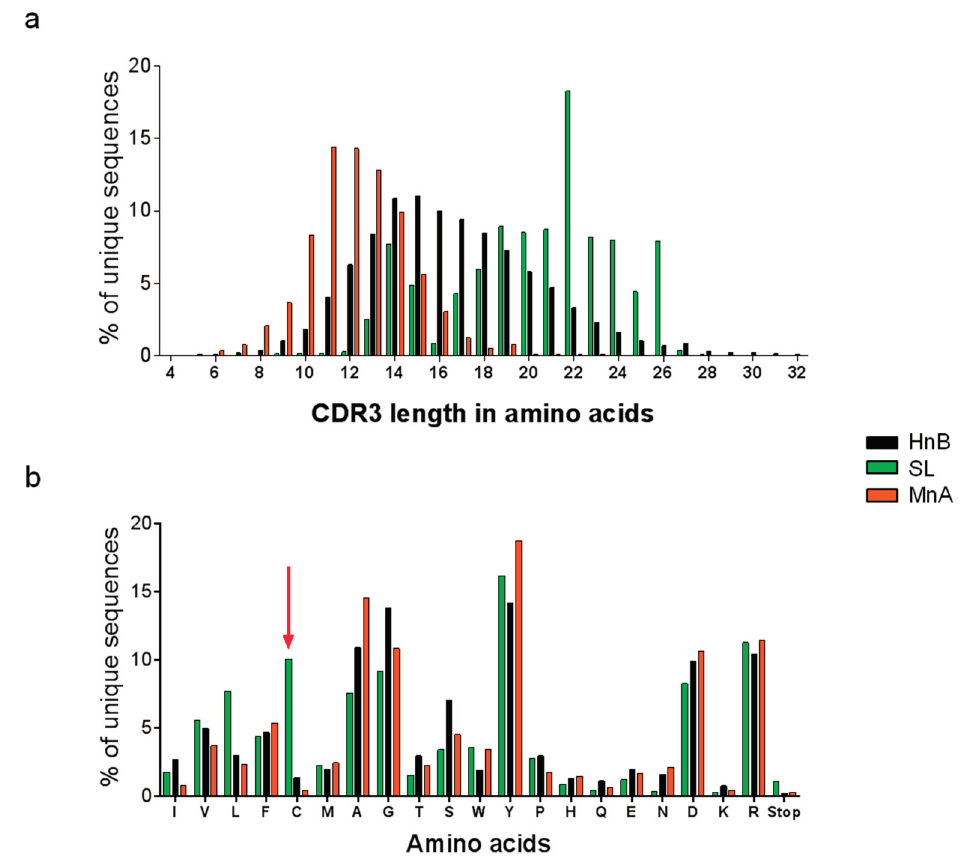
Figure 2. Library analysis of by next generation sequencing. ( a ) Comparison of the length profiles of unique CDRH3 sequences in each library. ( b ) Amino acid composition of unique CDRH3 repertoires. As expected from the library design, the SL library has a much higher content in cysteine than MnA and HnB (red arrow). Both CDRH3 length and amino acid composition profiles were analyzed by deep